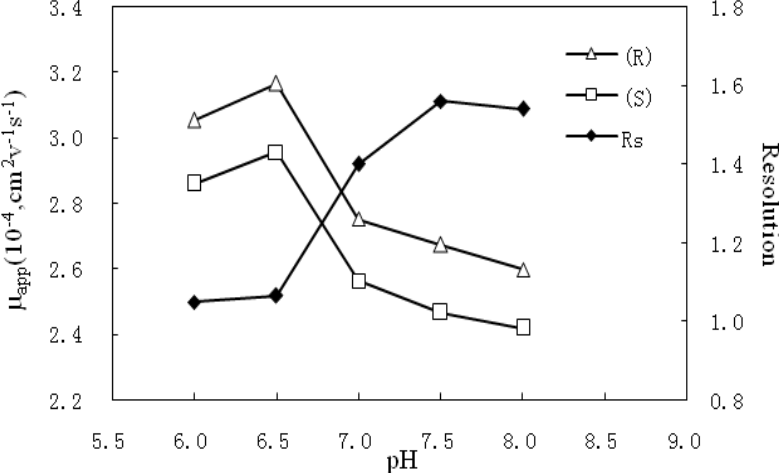
Figure 3. The effect of pH on resolution. Separation condition: 5 mmol/L SBE 20 mmol/L phosphate buffer containing 20% methanol; the other conditions are same as in